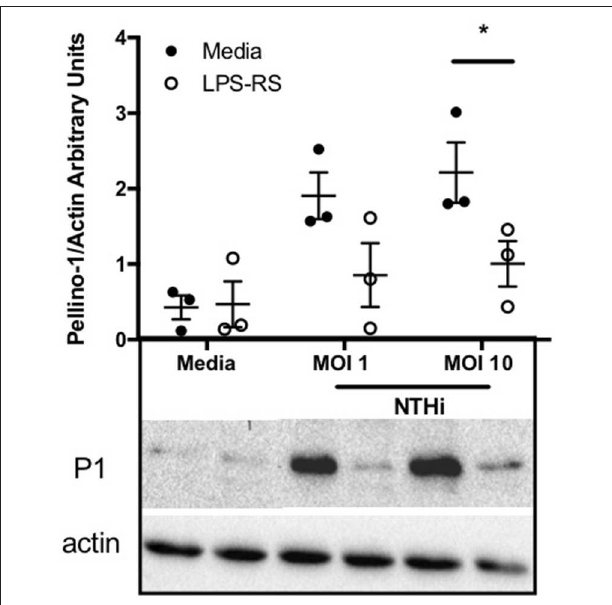
FIGURE 2 | NTHi-mediated upregulation of Pellino-1 occurs via TLR4. MDMs were stimulated with NTHi (MOI 1 or 10), or media control for 6h in the presence (open bars) or absence (black bars) of the TLR4 antagonist LPS-RS [1 µ g/ml]. Lysates were prepared and subjected to Western blotting using antibodies to Pellino-1 (P1) or actin (loading control). Representative blot as shown in inset. Densitometry was performed on 3 independent donors/experiments and data are presented as mean ± SEM. Statistically significant differences are indicated by * p ≤